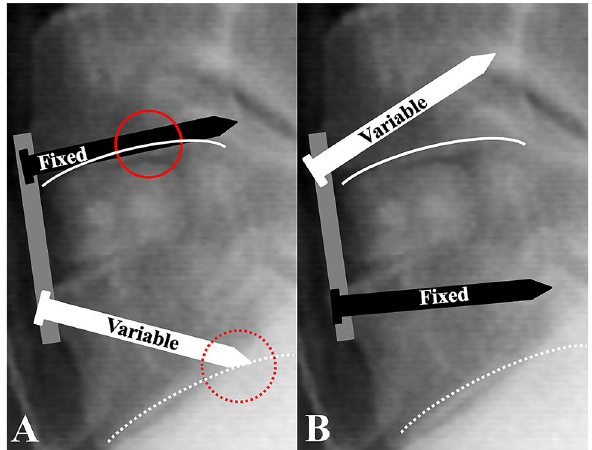
Figure 4. Avoiding endplate injury by selective caudal fixed screw construct. ( A ) Since the lower endplate of the cervical vertebra is shaped concavely in a sagittal plane fixed angled screw without high angulation has potential to injure the lower endplate of the cranial instrumented vertebra (red lined circle). Furthermore, due to the lordotic shape of cervical spine, variable screws are often inserted with more angulation than intended which could lead to injury of the lower endplate of the caudal instrumented vertebra (red dotted circle). ( B ) By using variable screws at cranial vertebra with greater angulation and fixed screw at caudal vertebra with less angulation, the risk of endplate injury could be